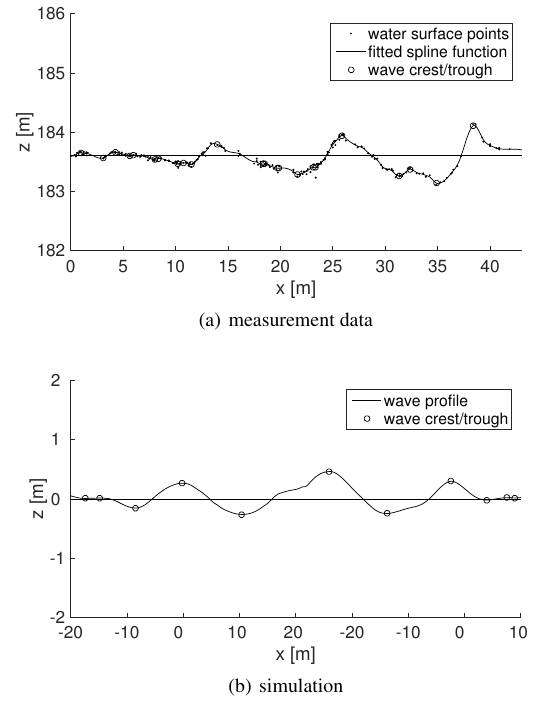
Figure 4. Water surface profile in measurement data (a) and simulation